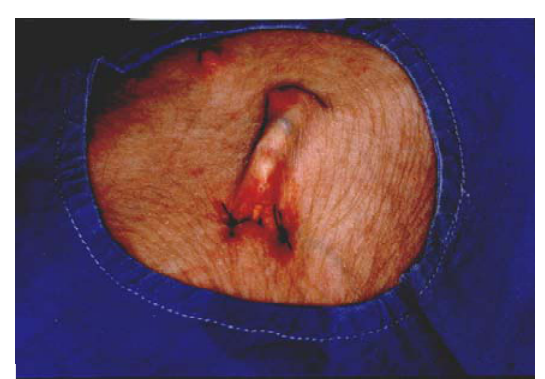
FIGURE 14 - Subcutaneus tunnel with the stump of Foley catheter and sutured skin.